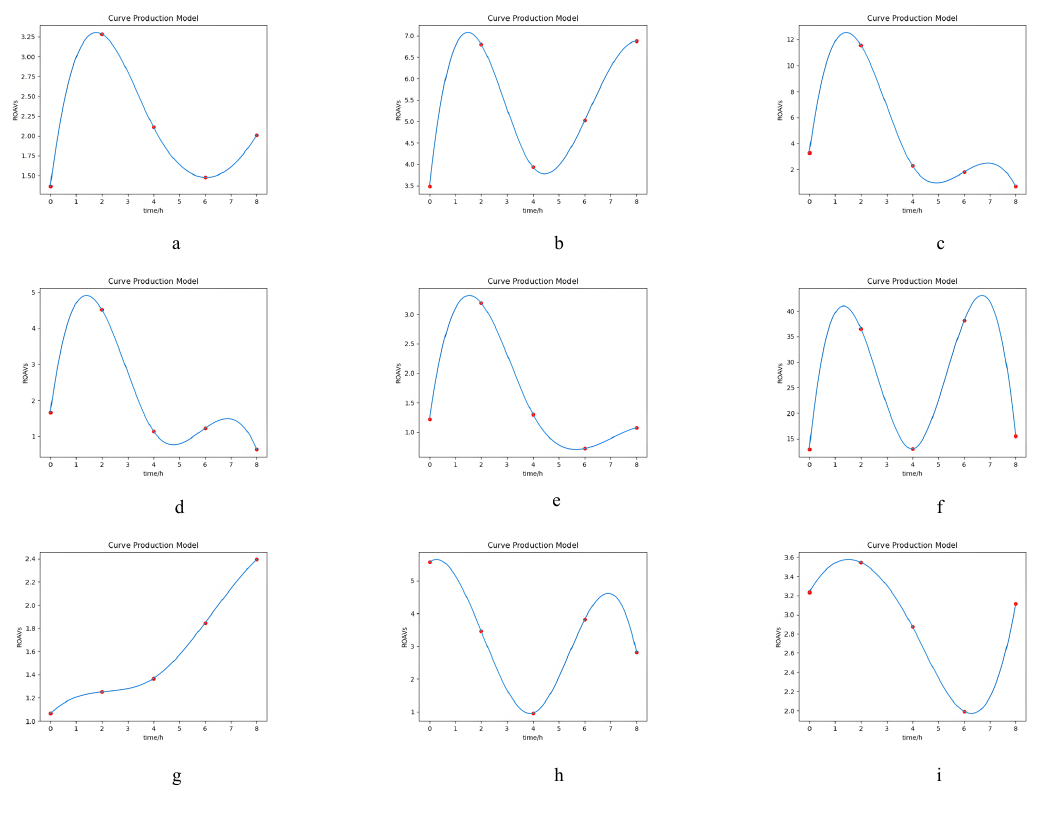
Figure 3. Fitting curves by different proxy models. Simulation of volatile component curves by three models: ( 1 ) Cubic Spline Interpolation; ( 2 ) Polynomial Curve Fitting; ( 3 ) Curve Prediction Model. Table 4. Prediction error of three proxy models in verification